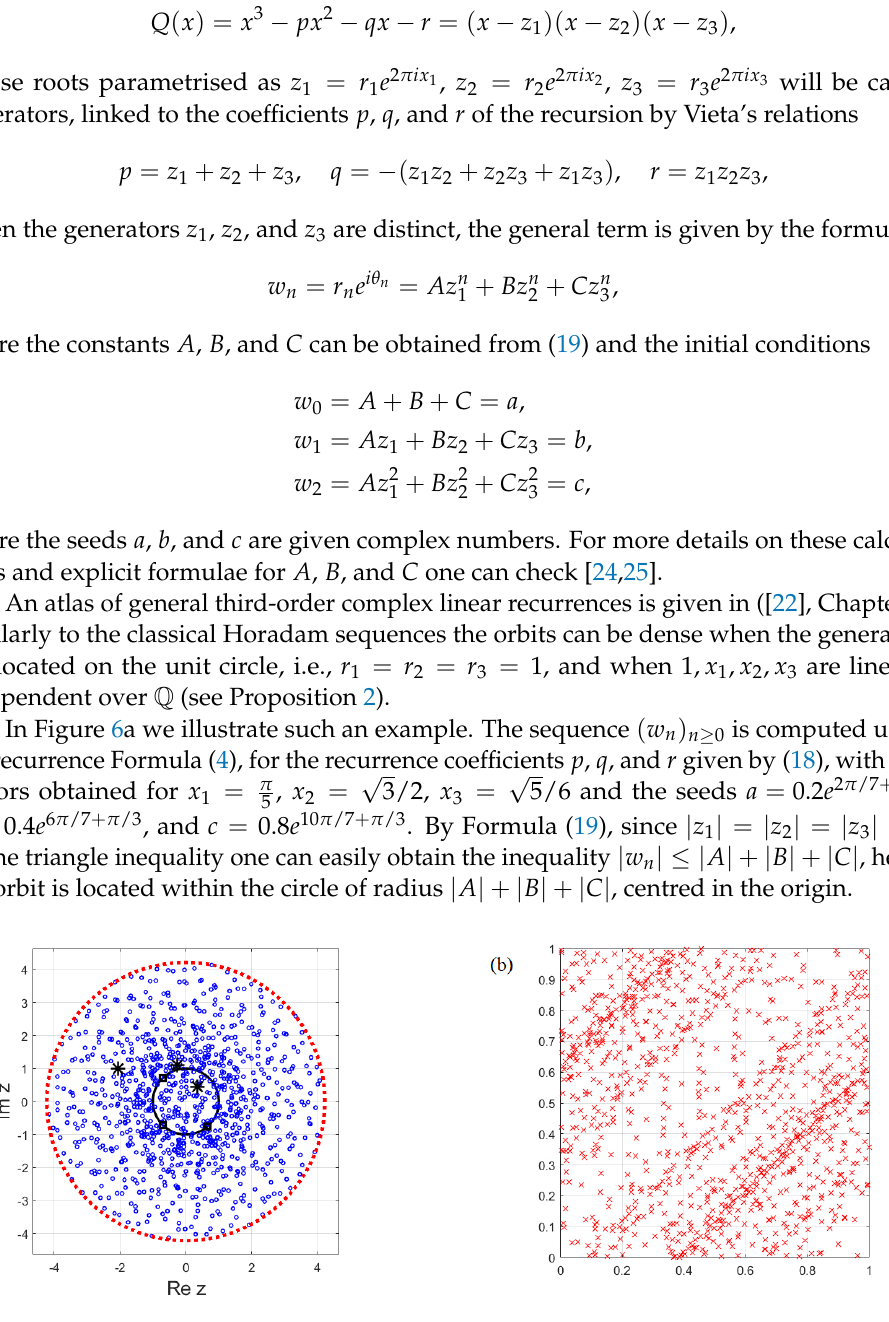
Figure 6. ( a ) First 1000 terms of the sequence ( w n ) n ≥ 0 from (4). The stars show the seeds a , b , c ; the squares indicate the generators z 1 , z 2 , z 3 ; the solid line is the unit circle U , while the dotted line is the circle U ( 0; | A | + | B | + | C | ) . ( b ) Plot of the points ( ˜ θ n , ˜ θ n + 1 ) (crosses), n = 0, . . .